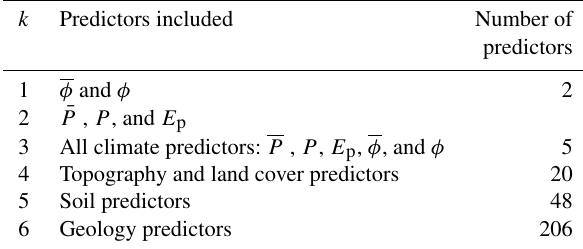
Table 4. Table of the six different predictor